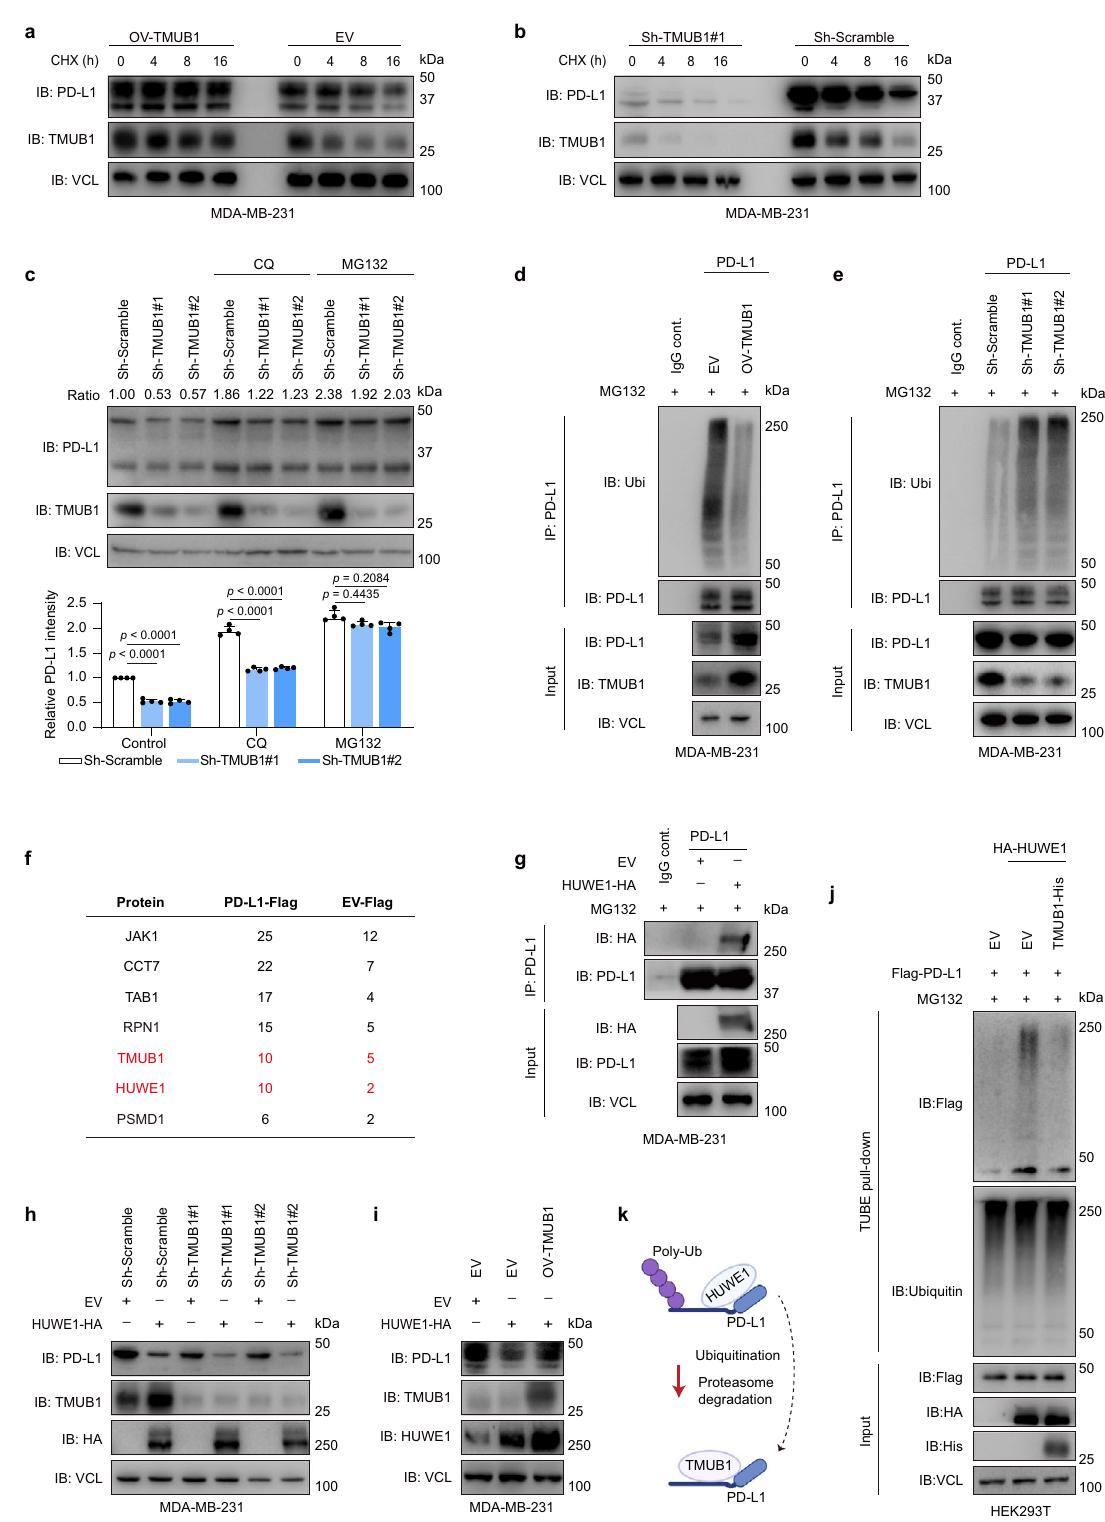
cing the binding of PD-L1 to